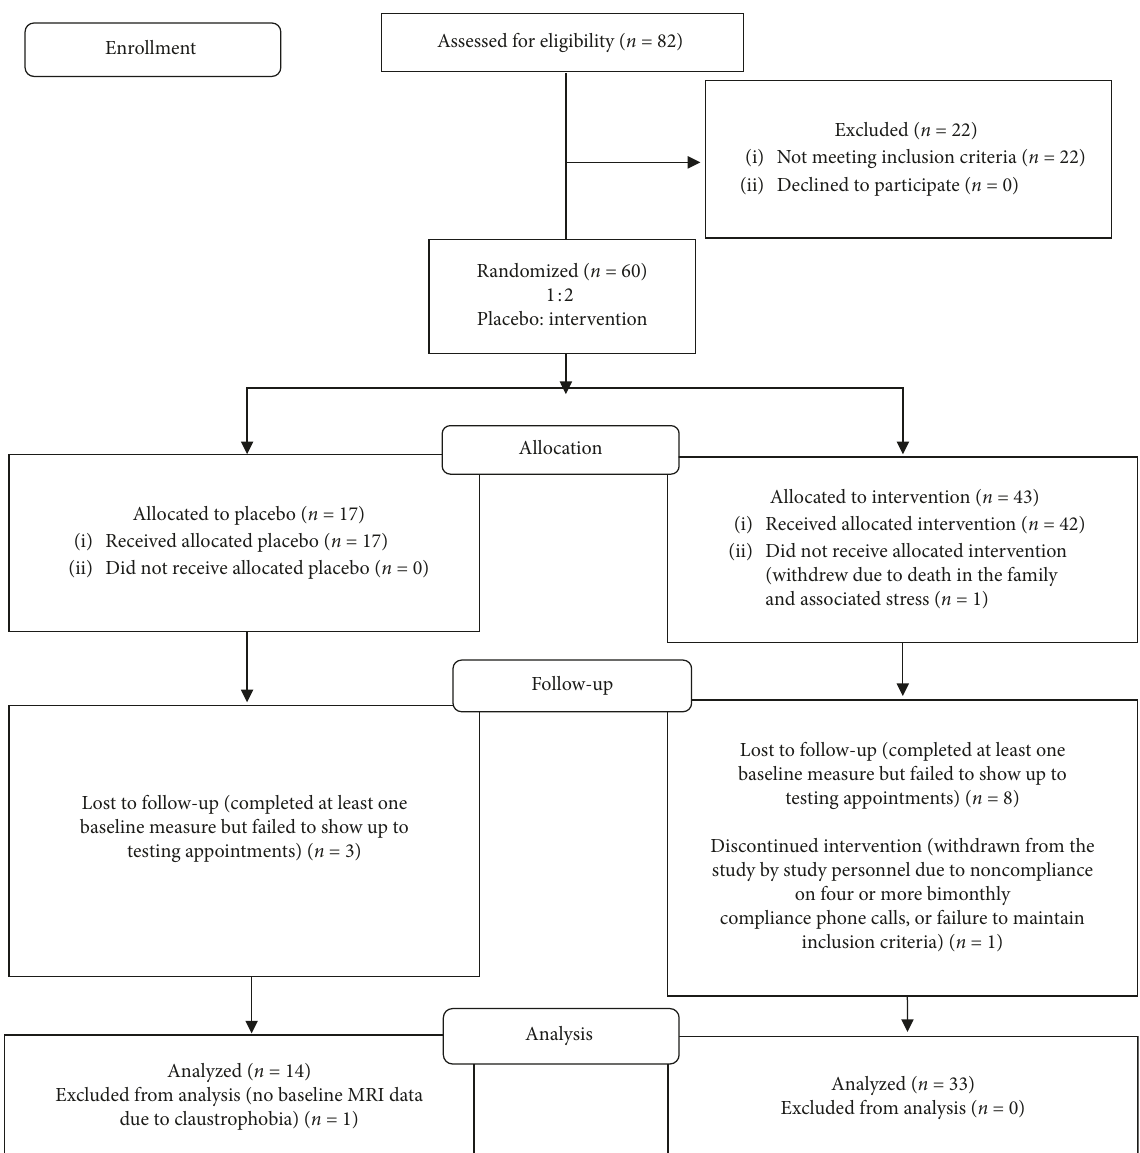
Figure 1: CONSORT flow